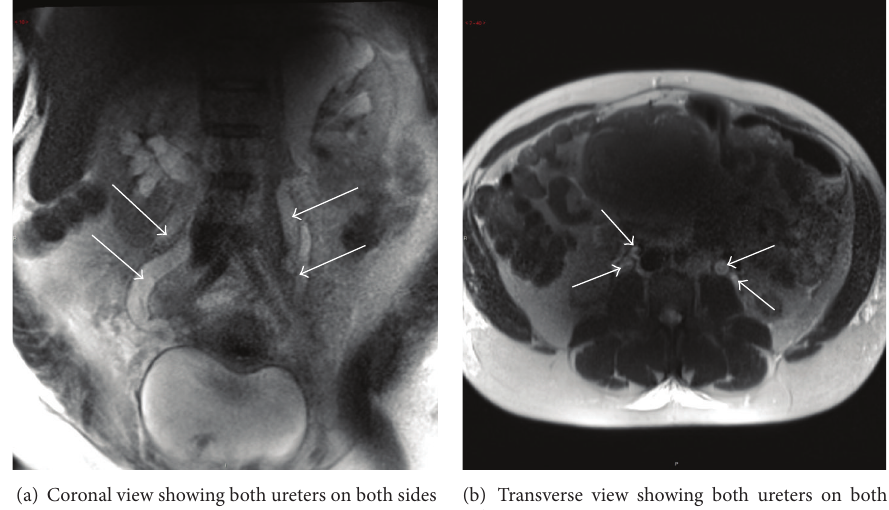
Figure 2: Abdominal Magnetic resonance imaging picture of the patient at day 2 post cesarean